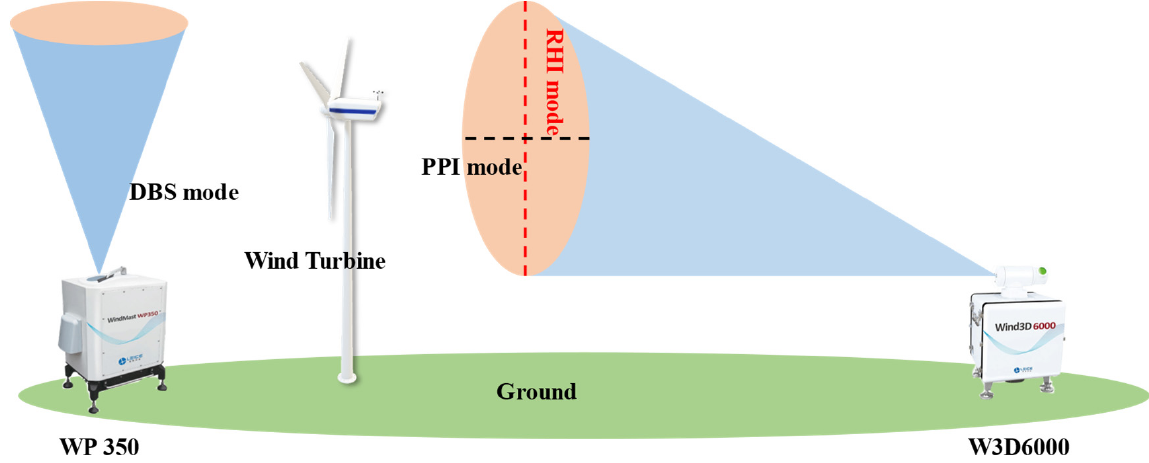
Figure 4. Schematic diagram of two types of lidar measurement.